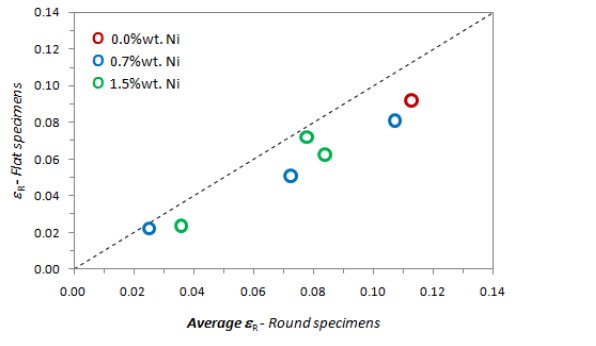
Figure 21. Comparison between tensile plastic behavior from round and flat tensile specimens: ( a ) tensile flow curves with round and flat tensile specimen of 1.5wt% Ni ADI from 25 mm Y-block austempered at 380 °C for 1 h; ( b ) differential data from the flow curves in ( a ) and strain hardening analysis based on differential Voce equation.